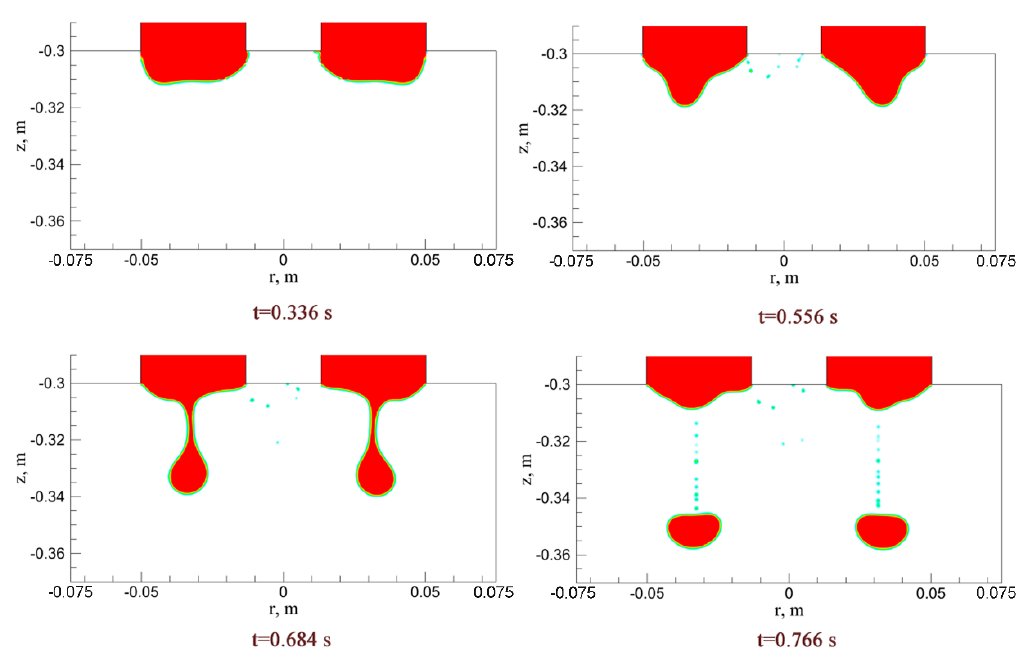
Figure 12. Formation and dripping process of droplet of TSCE-ESR.